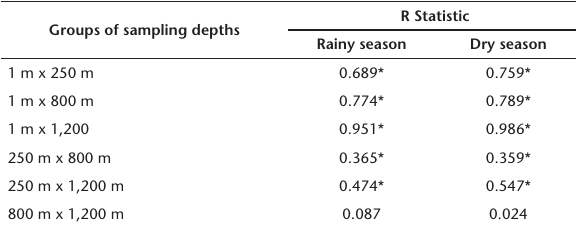
Table 3. Analyses of similarity (ANOSIM) between sampling depth groups during the rainy and dry seasons. R, strength of the difference between groups (* significant differences, p < 0.05).